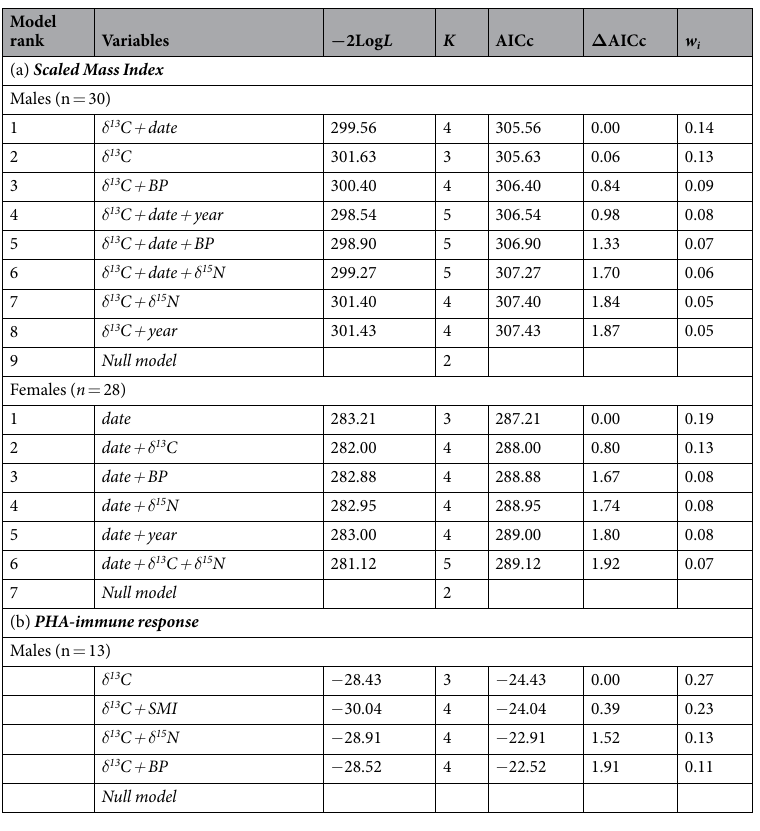
Table 2. Explanatory models of (a) size-corrected body mass (Scaled Mass Index) and (b) PHA-induced of godwits, selected according to Akaike’s information criterion adjusted for small samples (AICc). Only candidate models with ∆ AICc < 2 and the null model are ranked according to AICc weights ( w i ). K : the number of parameters in the model (including intercept and variance); BP: breeding plumage score; date: Julian